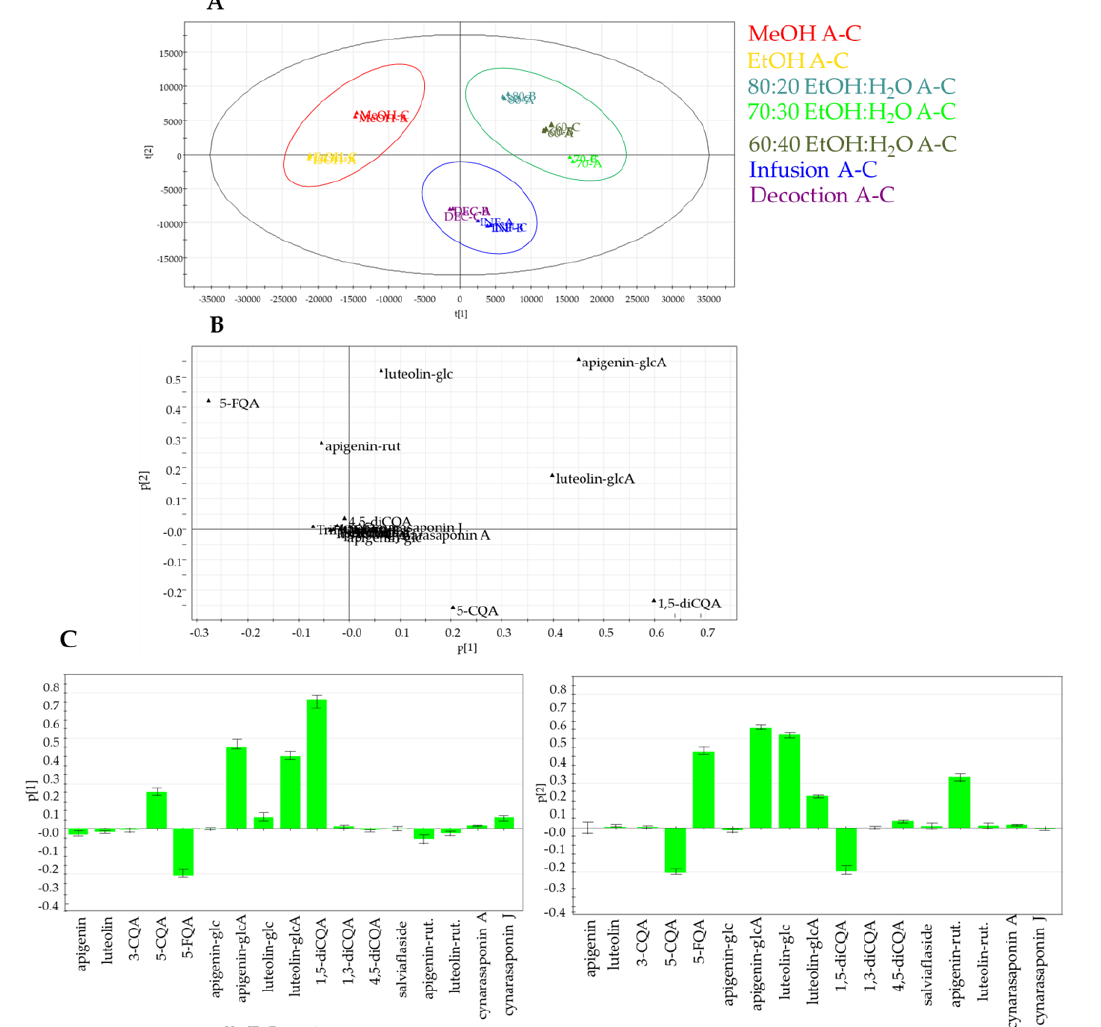
Figure 3. Principal component analysis of specialized metabolites in artichoke extracts obtained by LC-MS targeted analysis: ( A ) PCA score scatter plot; ( B ) PCA loading plot; ( C ) PCA loading column plots. CQA, caffeoylquinic acid; FQA, feruloylquinic acid; diCQA, dicaffeoylquinic acid; rut, rutinoside; glc, glucoside; glcA, glucuronide